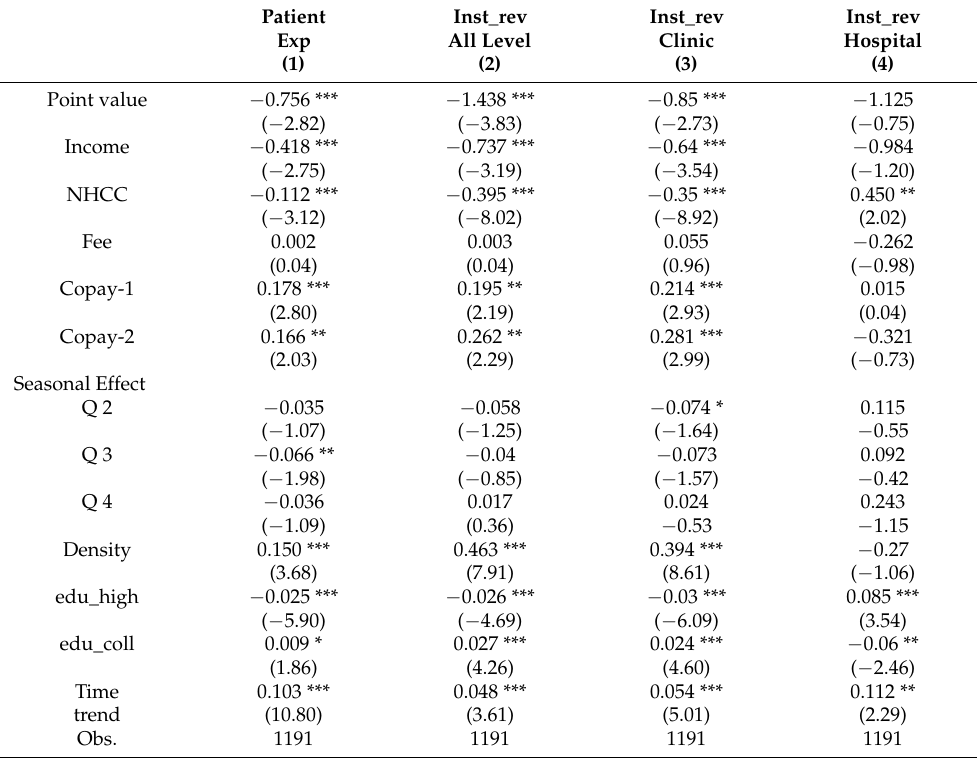
Table 6. GLS Analyses of Outpatient Expenditure (Revenue) by Institution Types–District Aggregate